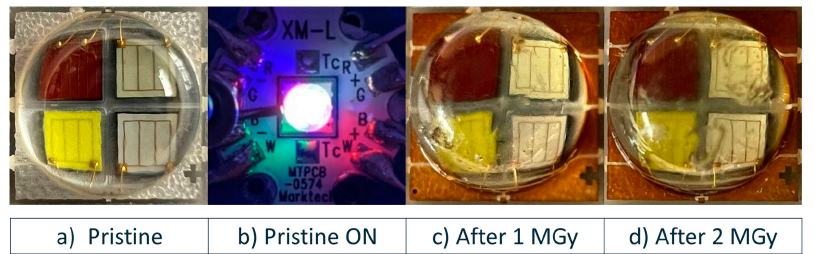
Figure 5. The LED structure in different conditions. The unirradiated NP1 sample is shown in its OFF ( a ) and ON ( b ) state. The LEDs depicted in the two rightmost pictures have been irradiated at the reported doses of 1 MGy ( c ) and 2 MGy ( d ). They refer to samples P2 ( c ) and I1M1 ( d ). Figures 5c,d illustrate the radiation-induced degradation of the LED structure at 1 MGy and 2 Mgy of dose, respectively. The two main macroscopic modifications of the materials composing the LED are highlighted. First, a radiation-induced darkening of the surface above the reflective layers surrounding the LED die is clearly visible. The surface color of the non-irradiated sample (Figure 5a) is white-ish, while it becomes progressively darker and brown-ish with dose, as shown in Figures 5c,d. Additionally, mechanical damages on the lens structure can be observed. They are particularly severe after irradiation at 2 MGy, and they appear in the form of the nicks and scratches visible above the four diodes. These damages might compromise the optical properties of the lens. For example, the diodes’ details in Figure 5d appear blurred and distorted in comparison to those observed in the non-irradiated sample. From handling, the lenses of all the LEDs irradiated at 1 MGy and 2 MGy appear hardened by radiation. The soft appearance and the elastic properties of the non-irradiated lens are compromised by radiation and permanently lost. The structural damage reported in some of the irradi- ated lenses probably originates from the post-irradiation handling and shipment. During these phases, the samples might have been accidentally exposed to unforeseen mechanical stresses, such as ones caused by uncontrolled impacts, leading to a permanent fracture of some of the lenses fragilized by radiation. Finally, it has been attempted to mechanically remove the lens to perform additional tests on the four LEDs without it. However, since the lens has been deposited over the contacts to provide the mechanical strength to keep them in place, its removal resulted in the rupture of the contacts, making the diodes unusable. This structural behavior of the lens is compatible with the hypothesis for which the lens is made out of silicone, as silicone is often used for the construction of LED lenses due to its flexibility [1]. Figure 6 shows some severe examples of LEDs’ mechanical degradation. Part of the lens is missing in sample I05M1, irradiated at 1.5 MGy (left picture), and the lens is badly damaged in several places in sample I1M2, irradiated at 2 MGy (right picture). A mechan- ical damage to the lenses is clearly visible from these pictures. This damage probably orig- inated during the transport of the samples to the irradiation facility for the two runs or during their post-irradiation handling. The damage is not uniform over the lens volume. Concerning the 1.5 MGy sample (Figure 6, left), the structural failure of the lens is more evident in the top sector of the device, and in particular with regards to the green LED.